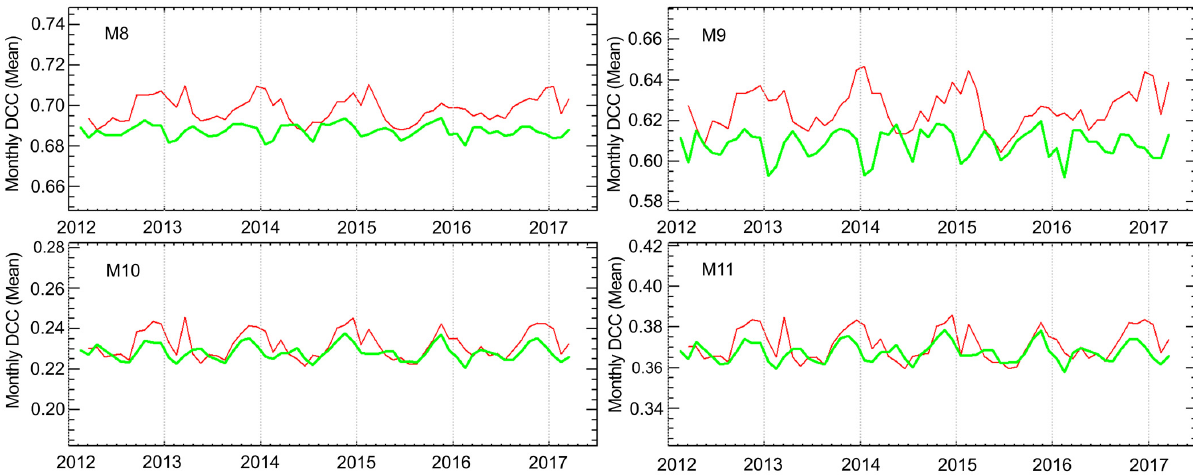
Figure 11. Suomi NPP VIIRS bands’ M8–M11 monthly DCC reflectance time series before (red color, operational) and after (green color) recalibration. Table 4. Statistics of monthly DCC time series for the operational and reprocessed Suomi NPP